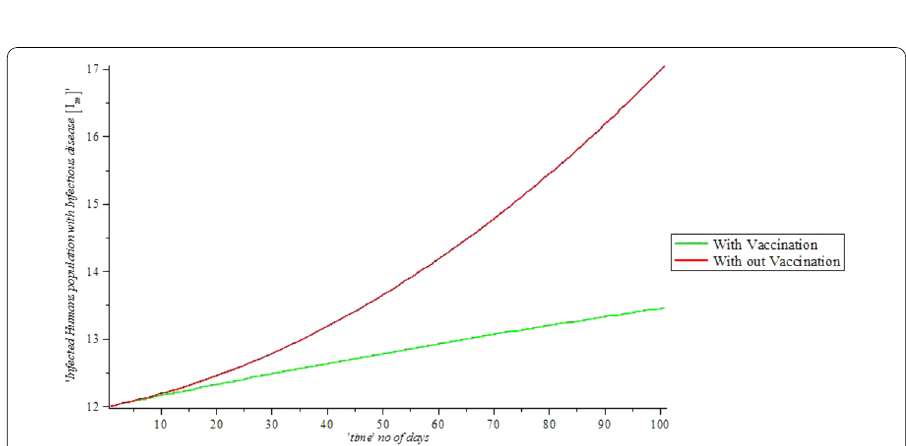
Figure 4 The optimal control strategy 2 using vaccination only